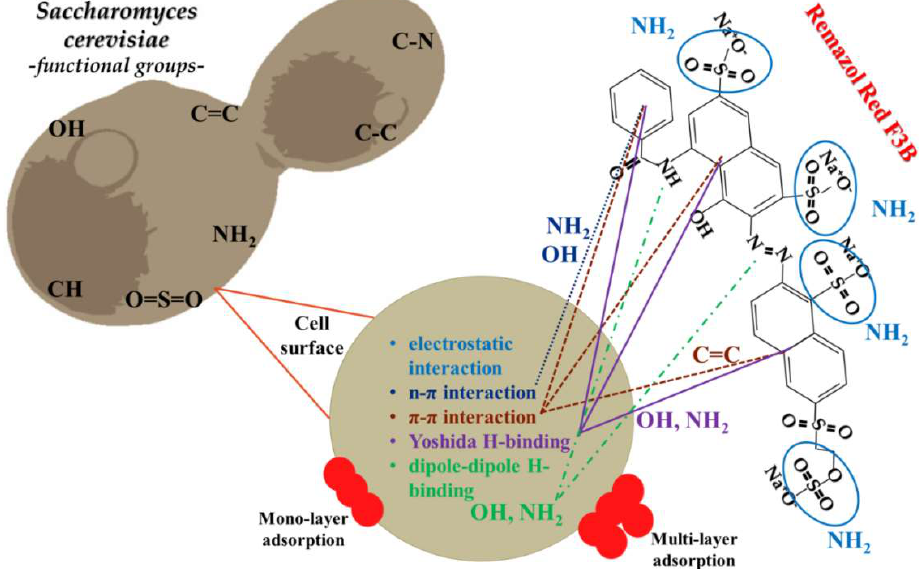
Figure 6 . Proposed interaction of RR dye with Saccharomyces cerevisiae brewery yeast . Figure 6. Proposed interaction of RR dye with Saccharomyces cerevisiae brewery